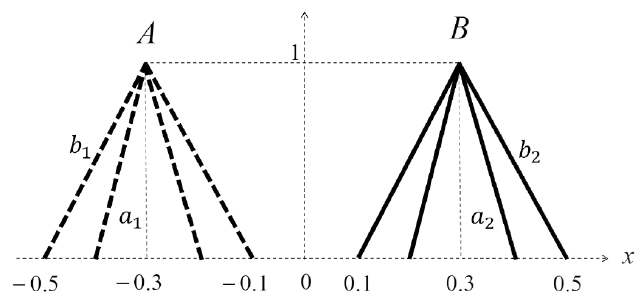
Figure 15. Support of two IT2FNs A and B .